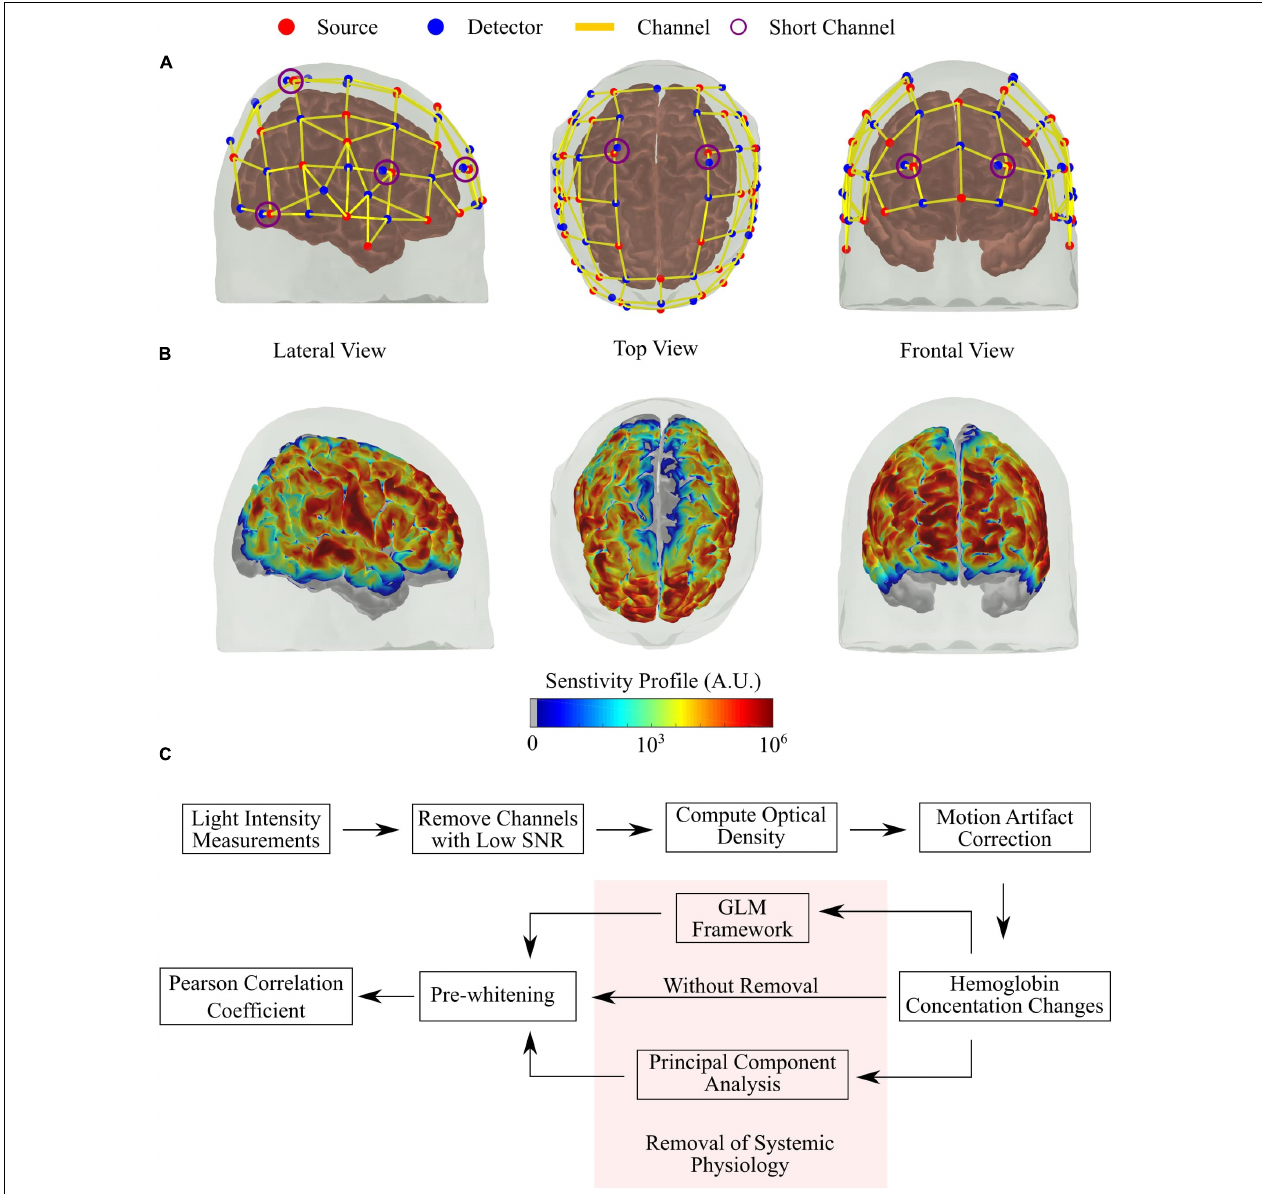
FIGURE 1 | Details of the optical probe and pre-processing steps employed. (A) Source-detector configuration of the optical probe used in the study, with 32 sources (red) and 39 detectors (blue), allowing 121 channels (yellow lines) with source-detector separation of around 3 cm and eight short channels (violet circles) with source-detector separation of 0.8 cm. (B) Sensitivity profile of the optical probe was obtained with Monte Carlo simulations, considering all channels. (C) Flow chart of the pre-processing steps used in this study. The highlighted part is the main focus of this work (see section “Removal of Systemic